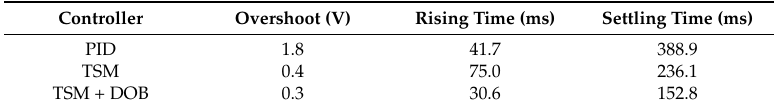
Table 2. Comparisons under proportional integral derivative (PID), terminal sliding mode control (TSM), and TSM + disturbance observer (DOB) at the